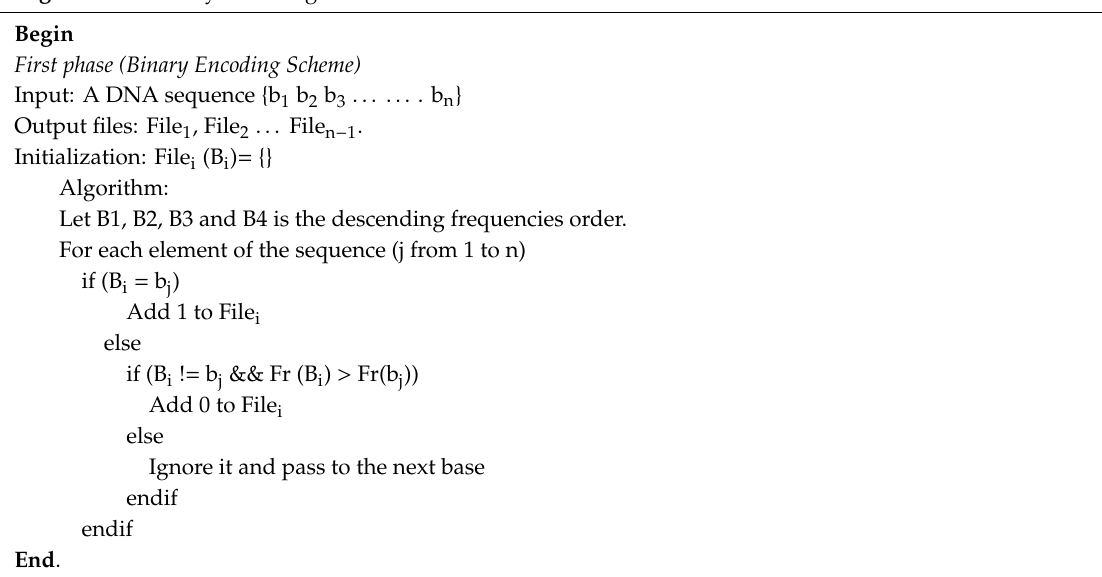
Algorithm 1 . Binary Encoding Scheme Algorithm 1. Binary Encoding Scheme